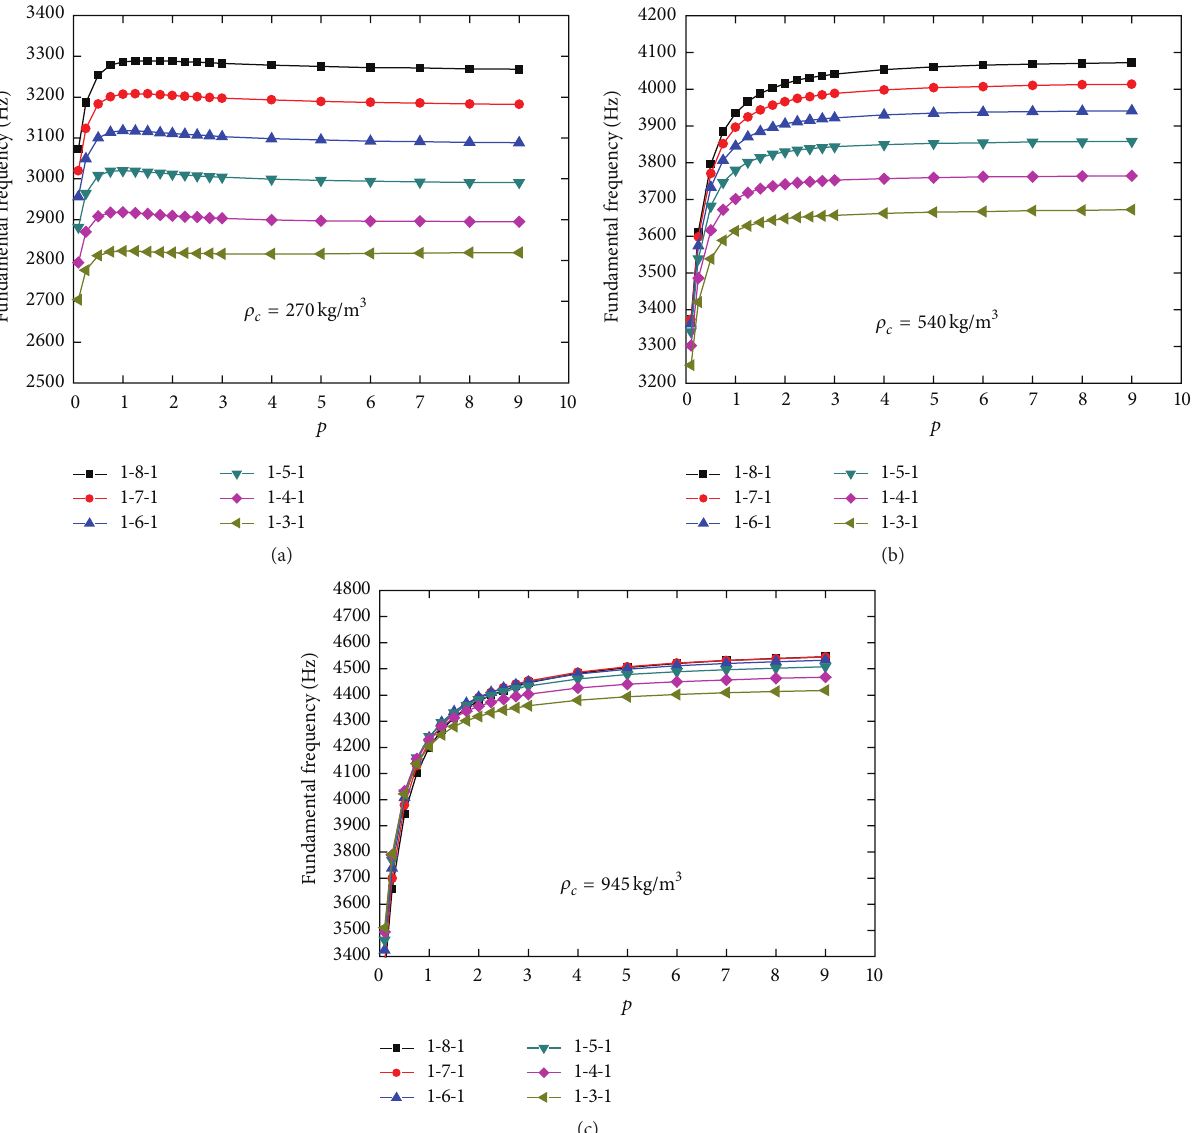
Figure 4: Fundamental frequency of the sandwich beams with different thickness ratios versus gradient exponent for different densities of foam core. (a) 𝜌 𝑐 = 270 kg / m 3 ; (b) 𝜌 𝑐 = 540 kg / m 3 ; (c) 𝜌 𝑐 = 945 kg / m 3